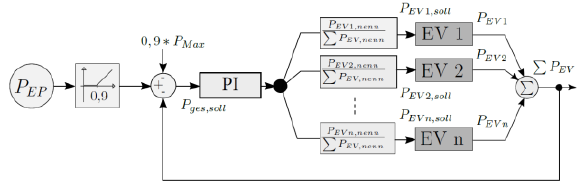
Fig. 9. Bottleneck